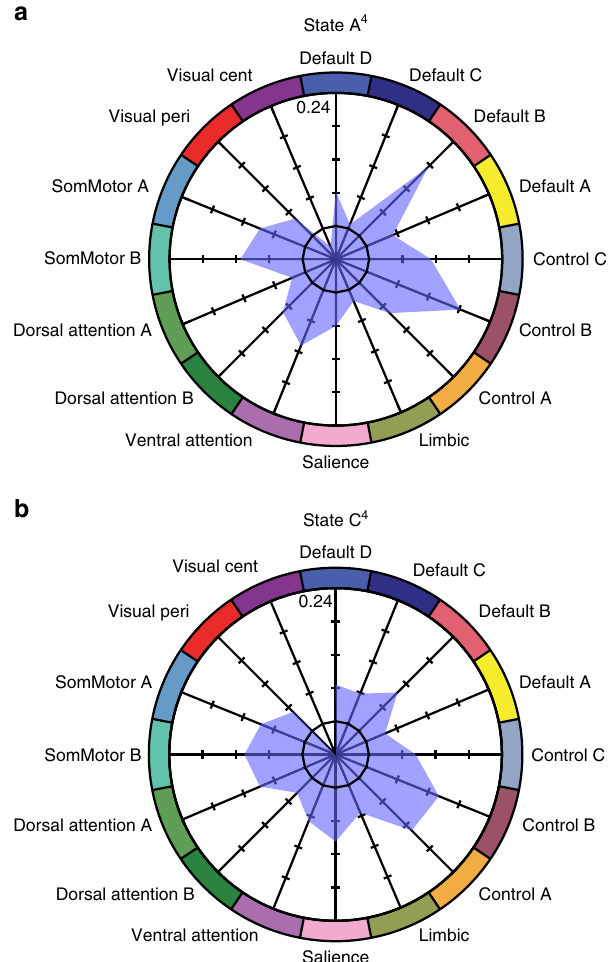
Fig. 7 State-speci fi c and state-general pro fi les of network dysregulation in psychosis. a , b Polar plots show percent difference in mean network connectivity between healthy comparison participants and individuals with psychotic illness for ( a ) state A 4 and ( b ) state C 4 (range: – 6 to 24%). The black hexadecagon re fl ects the mean network correlations for the healthy comparison sample, set to zero. Values outside the hexadecagon re fl ect decreased correlation strength for patients, relative to the healthy comparison